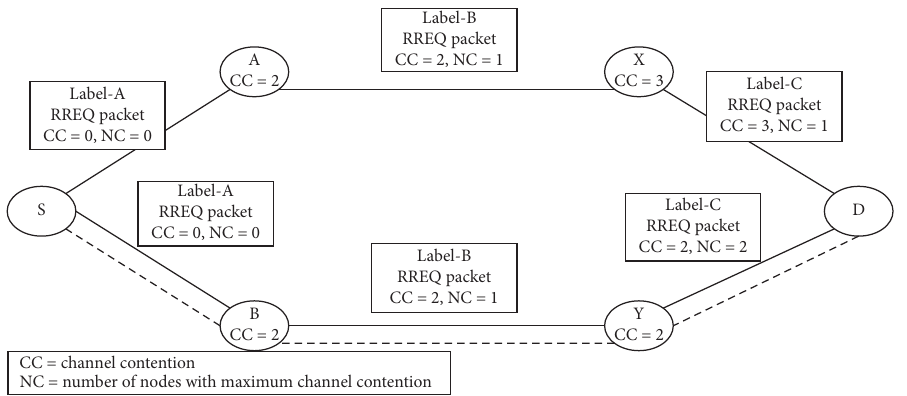
Figure 2: A wireless ad hoc network